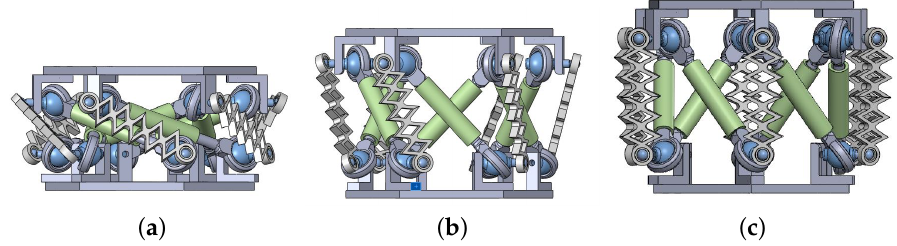
Figure 5. Single link CAD prototype. ( a ) Collapsed state. ( b ) Folding state. ( c ) Deployed